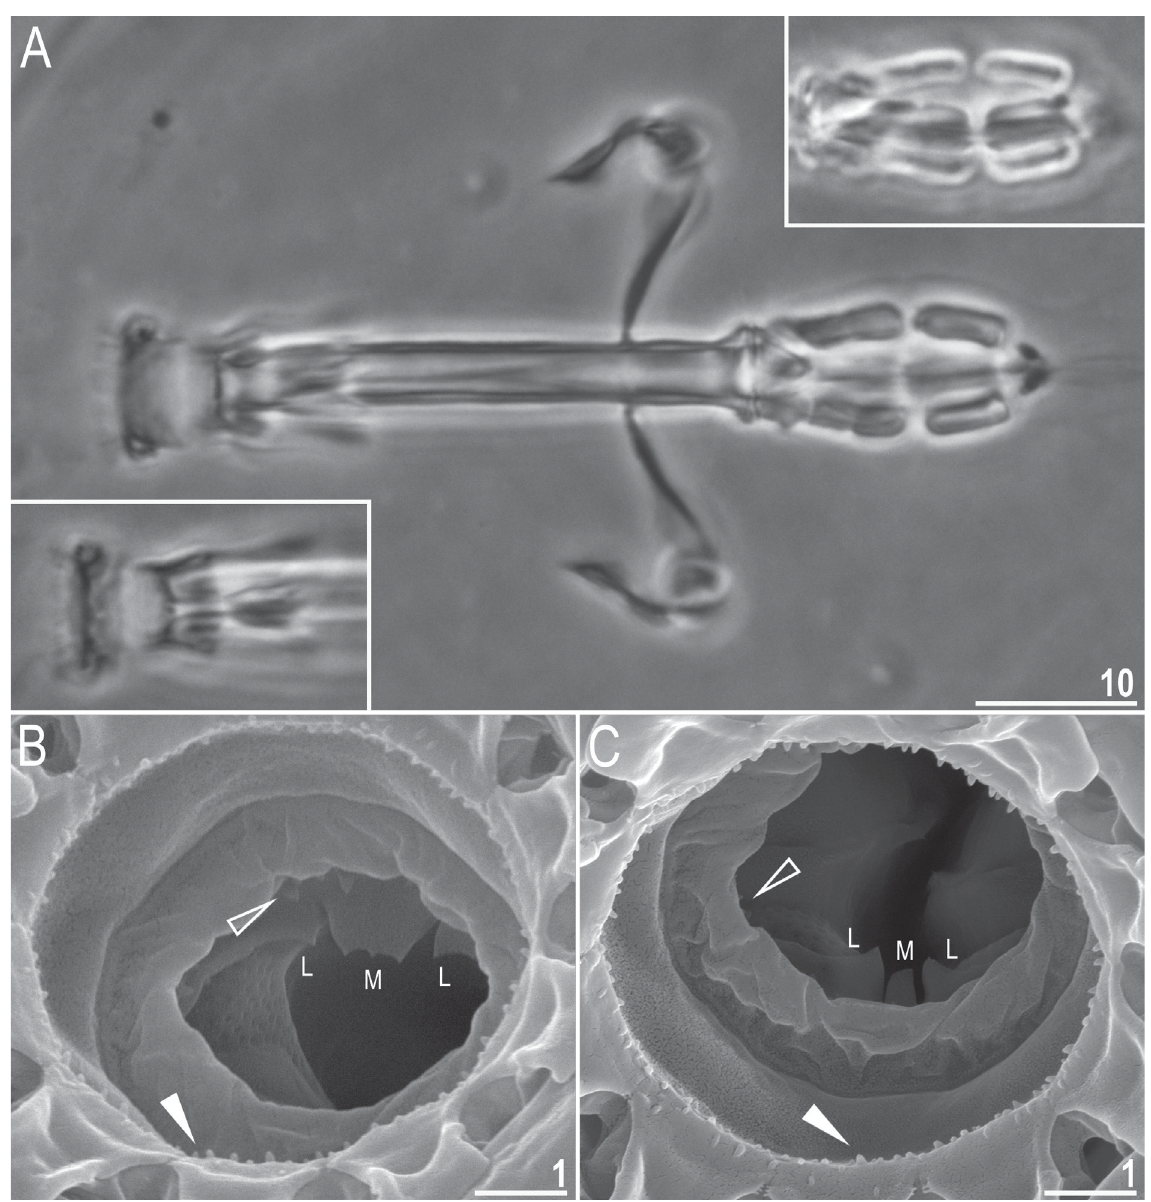
Fig. 4. Macrobiotus canaricus sp. nov., paratypes, buccal apparatus and the oral cavity armature seen under PCM and SEM. A . Dorsal projection of the entire buccal apparatus; the lower insert shows a ventral view of the oral cavity armature, the upper insert shows macroplacoid morphology (PCM). B–C . The oral cavity armature of a single paratype seen under SEM from different angles. Filled arrowheads indicate the teeth of the first band, empty arrowheads indicate the teeth of the second band, median teeth are marked with M, andlateral teeth are marked with L. Scale bars in